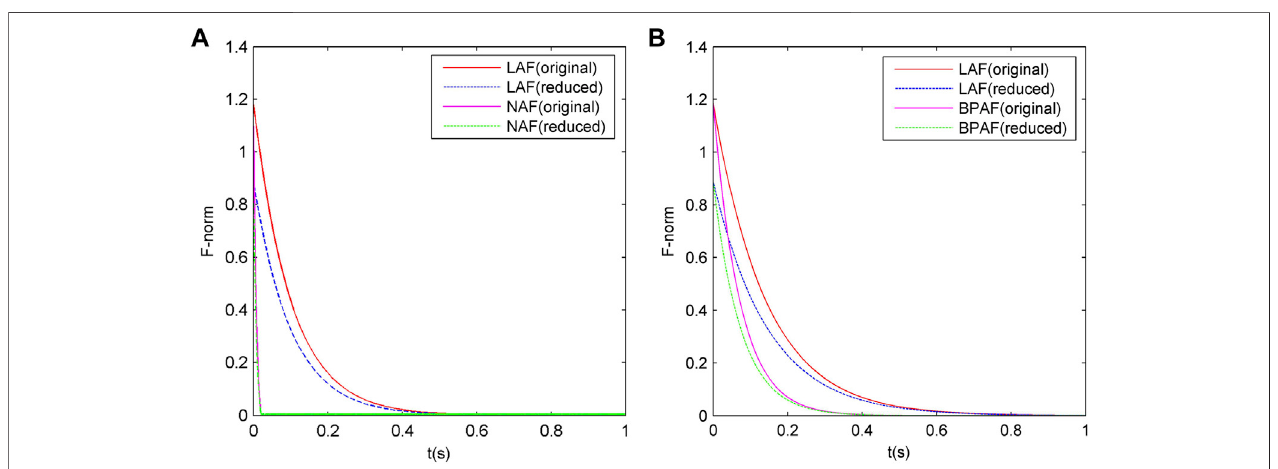
FIGURE 5 | Comparison of the convergence between the original-order and the reduced-order RNN models under Example 3. (A) is ZNN, (B) is GNN.